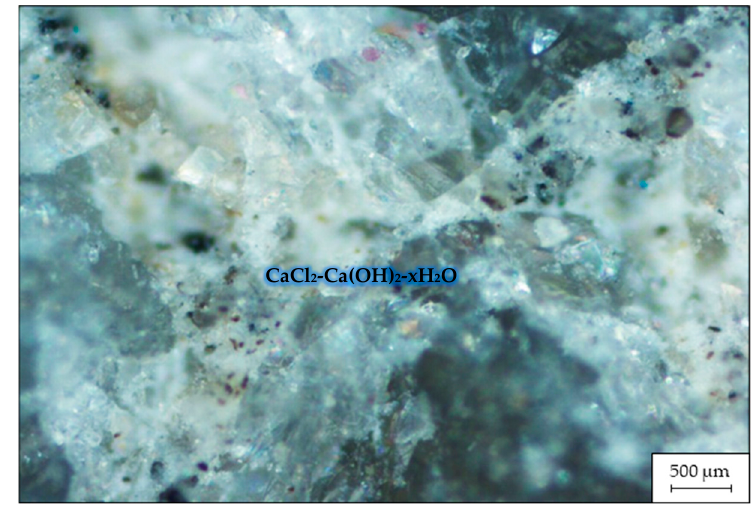
Figure 8. Microstructure of a fracture of the RHC containing CaCl 2 .